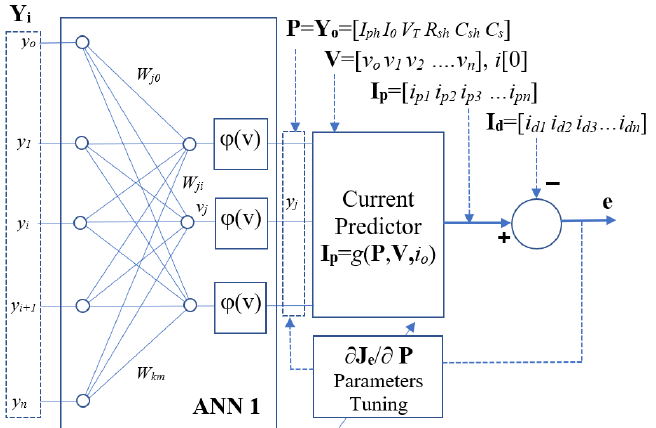
Figure 5 . Block Diagrams of the Single-layer ANN1+NCP parameters estimator .